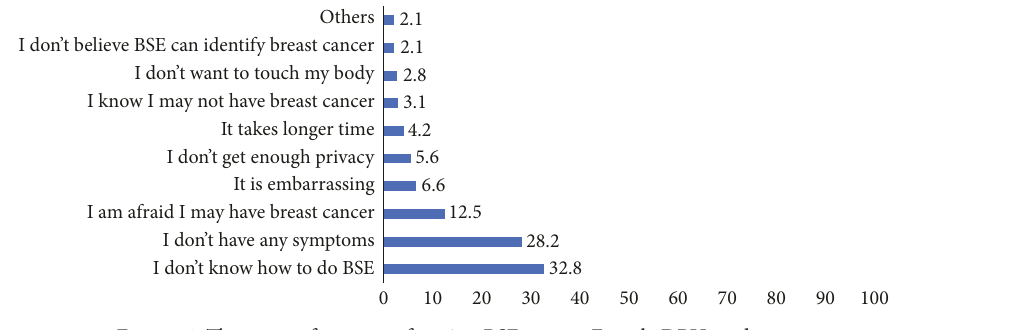
Figure 1: The reason for not performing BSE among Female DBU students. Table 4: Factors associated with practices of BSE among female DBU